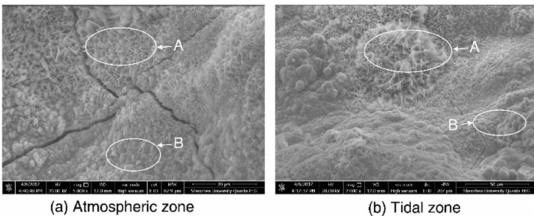
Figure 11. Scanning electron images of steel rust in The ( a ) atmospheric and ( b ) tidal zone.